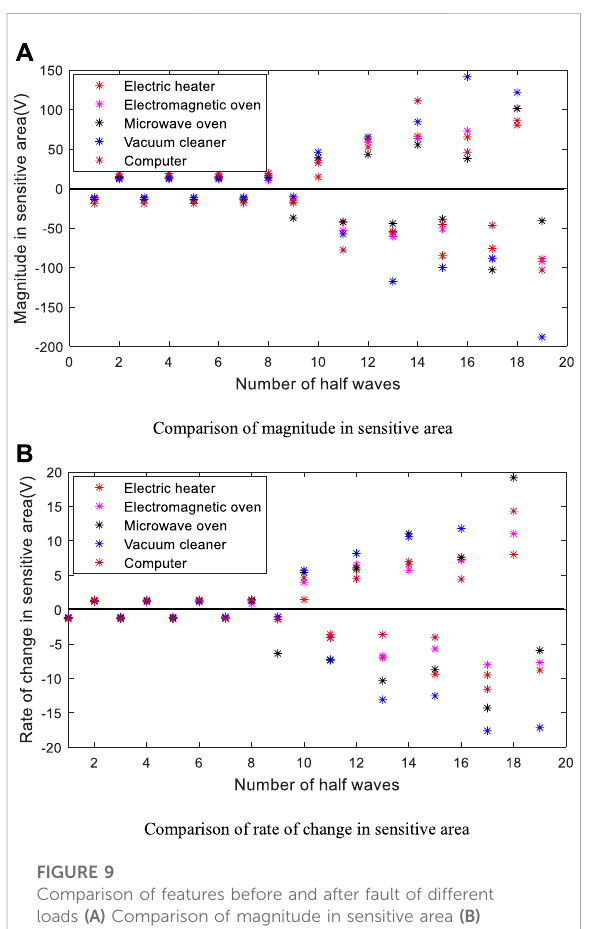
FIGURE 9 Comparison of features before and after fault of different loads (A) Comparison of magnitude in sensitive area (B) Comparison of rate of change in sensitive area.